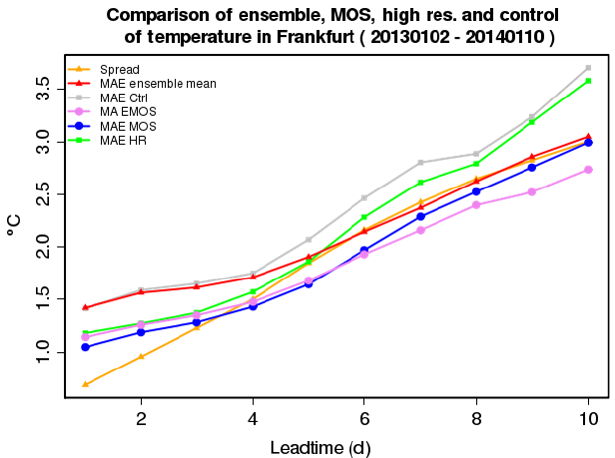
Figure 11. Mean absolute error (MAE) of 2m temperature forecast and error estimations depending on forecast lead time. Spread (yellow): spread of ECMWF-ENS (normalised to MAE); MAE Ensemble Mean (red): MAE of the mean of ECMWF- ENS; MAE Ctrl (grey): MAE of the ECMWF-ENS control run; MA EMOS (pink): Ensemble-MOS forecast of its own ab- solute errors (see Eq. 3: estimations of MAE EMOS, blue); MAE MOS (blue): MAE of Ensemble-MOS for ECMWF-ENS; MAE HR (green): MAE of high-resolution